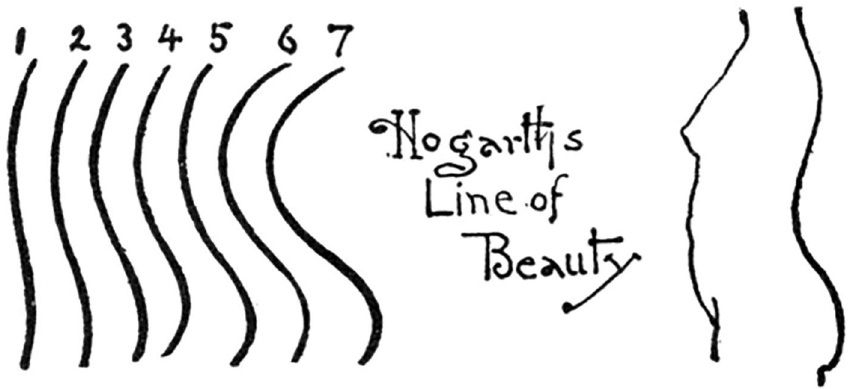
Figure 2. Part of the figure on page 94 in Poore 13